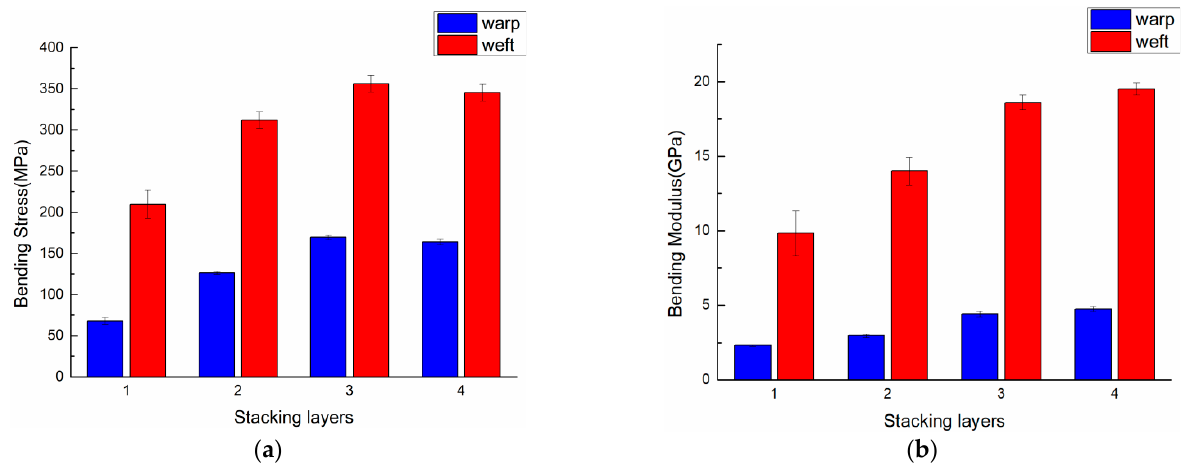
Figure 6. Comparison of the bending properties of materials with different stacking layers. ( a ) Bending strength. ( b ) Bending stiffness.